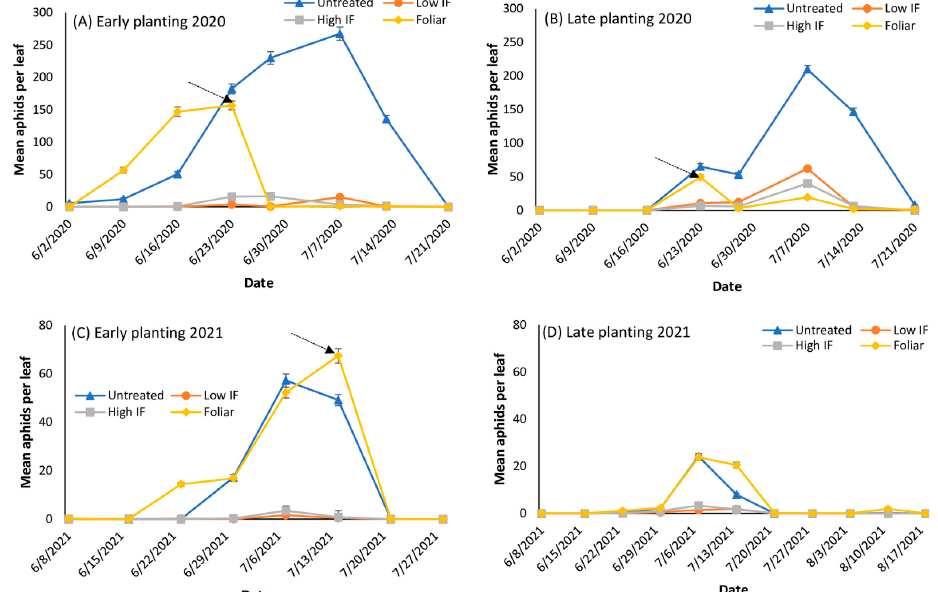
Figure 1. Mean number (±SE) of Melanaphis sorghi on bottom leaves for early ( A ) and late ( B ) planting in 2020 and for early ( C ) and late ( D ) planting in 2021 on grain sorghum in Tifton, GA. The arrow indicates timing of foliar insecticide application. Forage sorghum in the 2021 late planted sorghum did not receive a foliar insecticide application because M. sorghi populations never reached the threshold. The four insecticide treatments are: the untreated, low in-furrow (IF), high IF, and foliar applications with flupyradifurone.